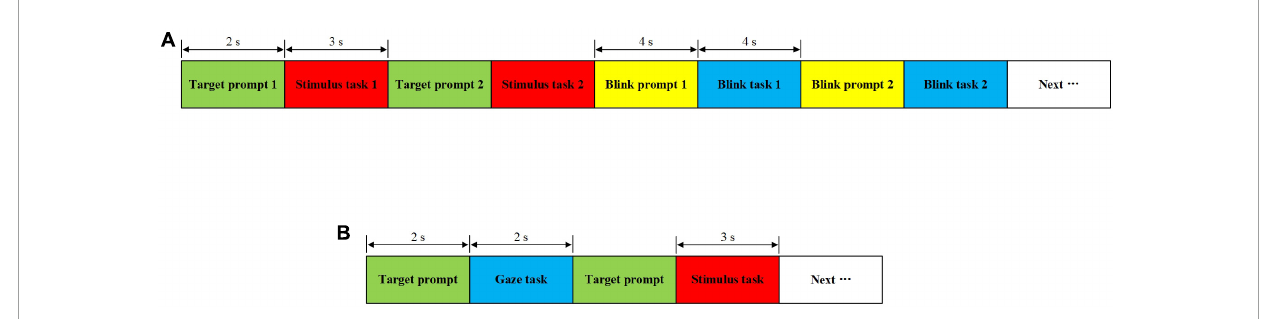
FIGURE5 Schematic diagram of the offline experiment procedure. (A) Offline simultaneous mode. (B) Offline sequential mode.